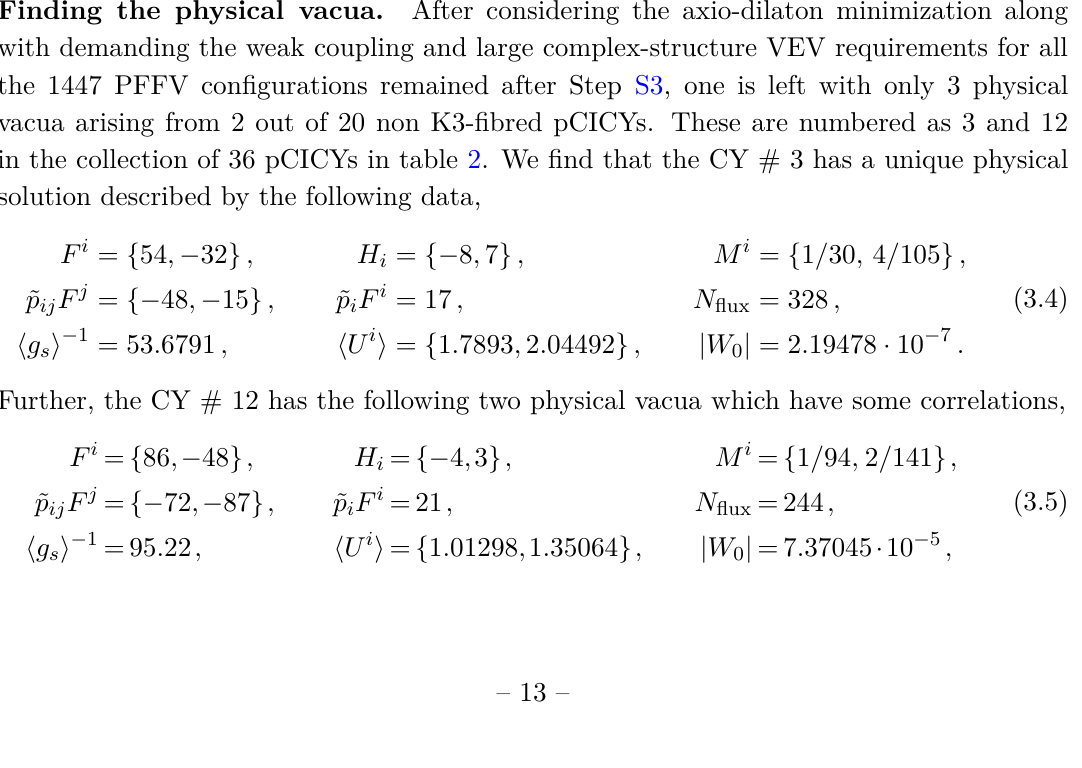
50 n where n = { 1 , 2 , . . . , 10 } flux ≤